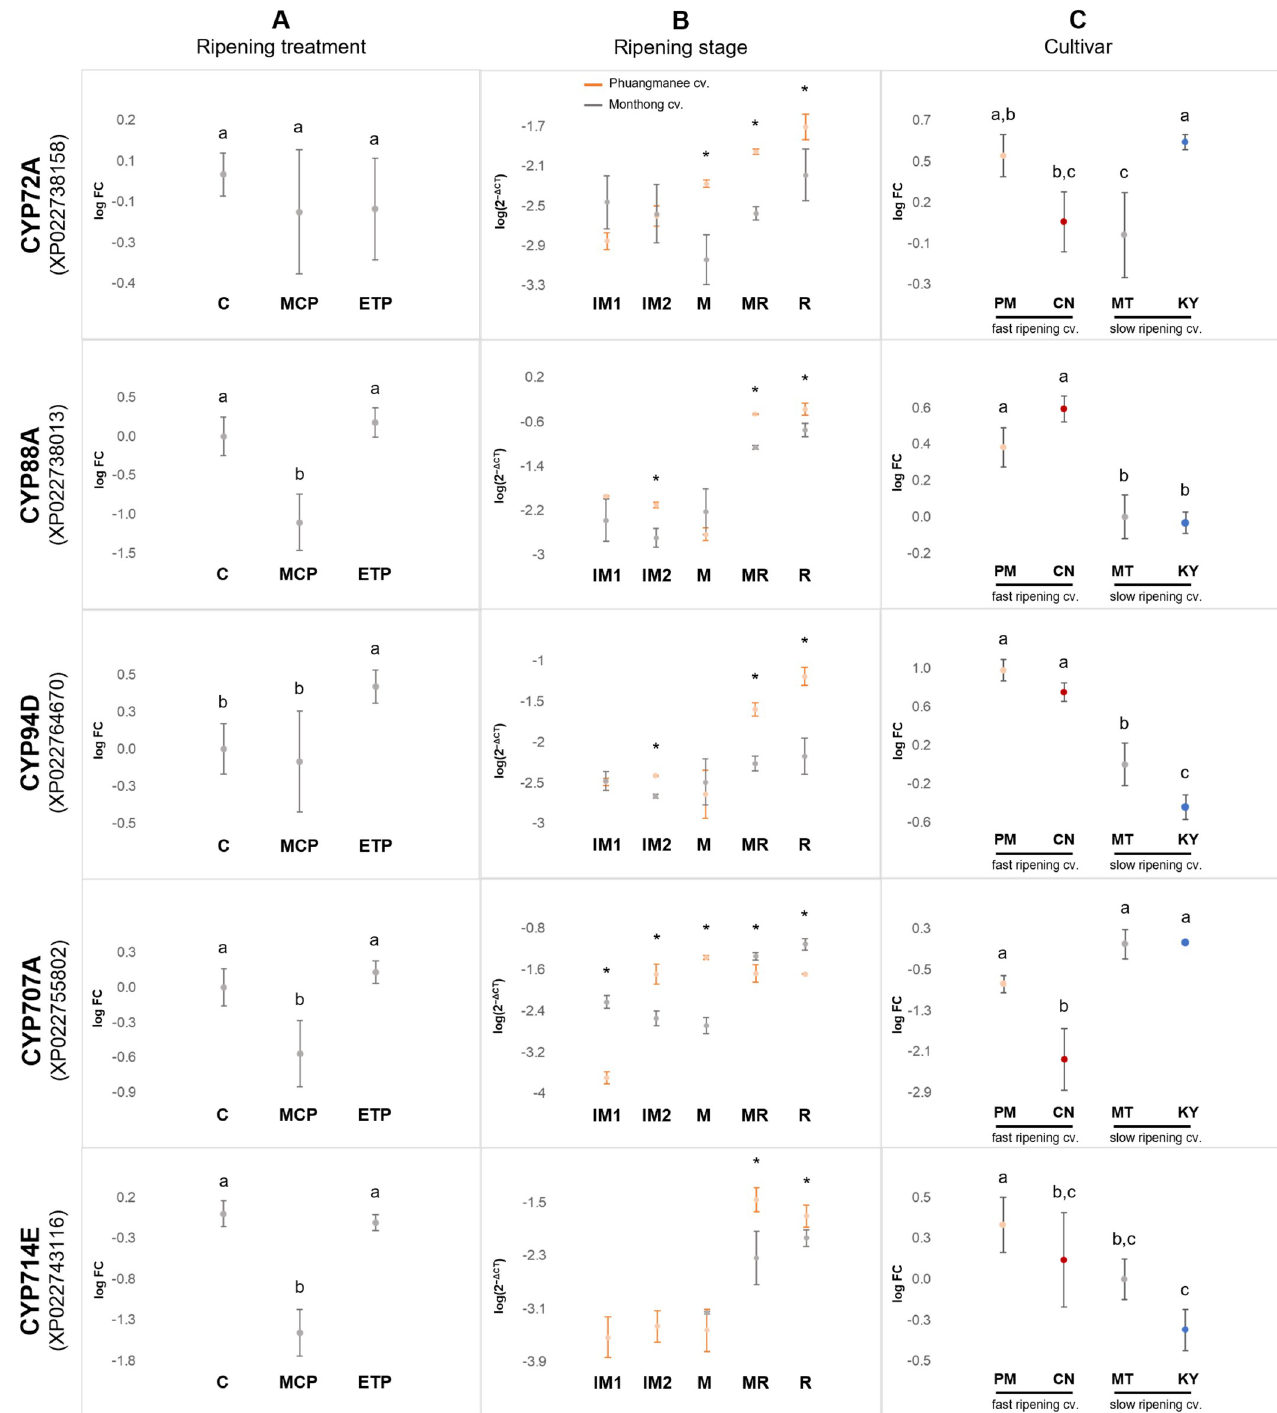
Fig 4. Relative expression of durian P450s. (A) Expression profiles in Monthong fruit treated with exogenous 1-methylcyclopropene (MCP) or ethephon (ETP) at the ripe stage, in relative comparison with untreated fruit (control; C). Five biological replicates were employed for each treatment. Dots and error bars represent the means and standard deviations of log(2 − ΔΔ CT ), respectively. Tukey’s HSD tests were used for statistical calculations ( p = 0.05). The same letter above the error bars indicates no significant difference. (B) Expression profiles during five ripening stages in Phuangmanee cultivar (orange dots) and Monthong cultivar (grey dots). Three biological replicates for each cultivar and stage were employed. Dots and error bars represent the means and standard deviations of log(2 − Δ CT ), respectively. Asterisks indicate the significance between two cultivars at the same stage, calculated by a t-test ( p = 0.05). The expression